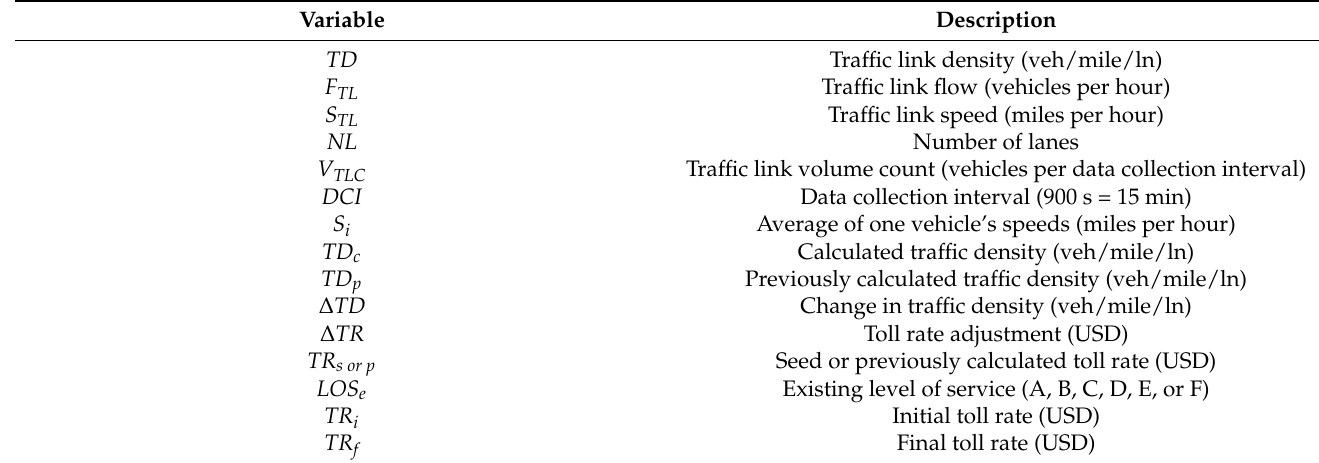
Table 1. Variable